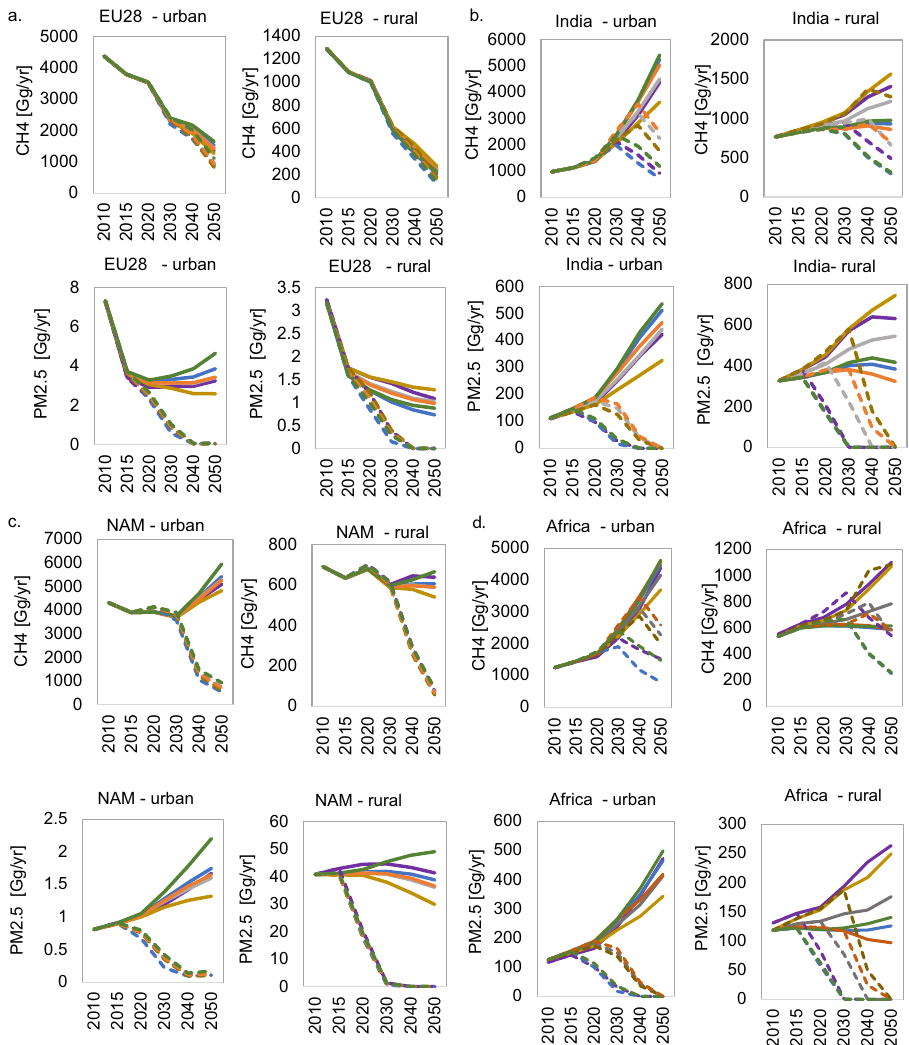
Fig. 6 Regional emissions of CH 4 and PM 2.5 from municipal solid waste. a EU28, b India, c North America (NAM), d Africa. The target of all modeled scenarios is set to reach ~100% of MSW collection and management by 2050. The environmental co-bene fi ts will be obtained at different levels upon the level of socio-economic development and political and institutional arrangements. The different assumptions on policy interventions are then translated into a wide range of future